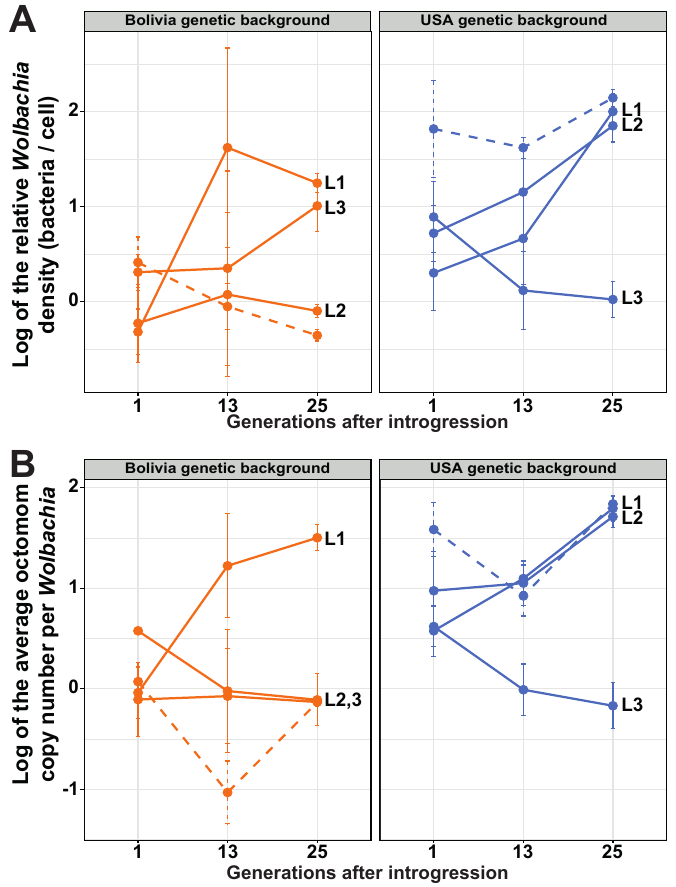
Figure 4: Replicability of the infection patterns after a new introgression procedure, and their evolution over generations. 4A: relative Wolbachia density (log; median ± SE), 4B: average Octomom copy number per Wolbachia (log; median ± SE), n = 5 / line / timepoint. Each color represents a host genetic background. Plain lines represent the replicate lineages from the new introgression procedure (MP2), L1, L2 and L3 indicating the replicates. Dashed lines represent the lineages from the initial introgression procedure (MP1), which were set as references in the statistical analyses. Just after the introgression event (t = 1), the relative Wolbachia density and the average Octomom copy number per Wolbachia did not differ significantly between the Bolivia-MP2 replicate lines and the Bolivia- MP1 line from the first experiment used here as the reference (Linear regression model; experiment group effect on relative density: P > 0.1; experiment group effect on Octomom copy number: P > 0.1; see statistical details in Table s4). The relative density and Octomom copy number in Wolbachia from the Bolivia-MP2 replicate lines did not differ significantly between replicates (see pairwise comparisons in Table s5), which does not contradict a host determinism for density regulation trough Octomom copy number selection in this genetic background. However, at the same timepoint (t = 1), the relative density and the average Octomom copy number in Wolbachia from the USA-MP2 replicate lines tend to differ from the USA-MP1 line from the first experiment used here as the reference (Linear regression model; experiment group effect on relative density: P = 0.08; experiment group effect on Octomom copy number: P = 0.025; see statistical details in Table s4). The relative density and the average Octomom copy number in Wolbachia from the USA-MP2 replicates lines did not differ between replicates (see pairwise comparisons in Table s5) and the number of octomom copies per Wolbachia did not show significant difference with the donor line (w1118-MP) (Linear regression model; maternal transmission effect on Octomom copy number: P = 0.35; Table s4). These results are more consistent with a maternal transmission effect from the donor line to the recipient ones, with infection patterns mirroring the bacterial composition of the donor